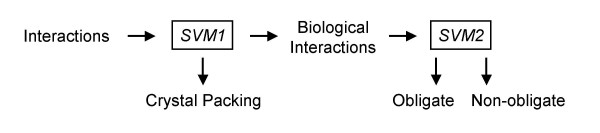
Schematic plot of the two-stage SVM. If an interaction is classified as crystal packing by SVM1, it will not be considered by SVM2; otherwise it is classified by SVM2 as either obligate or non-obligate interaction.